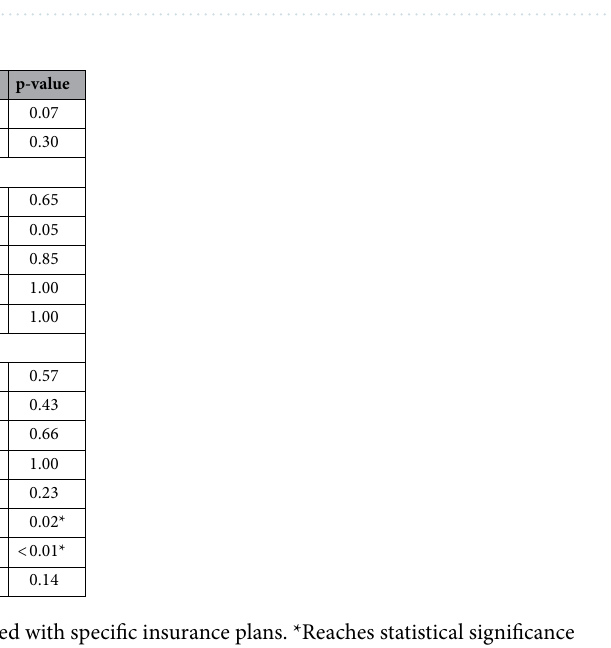
Table 2. Results of regression performed with insurance coverage as a binary variable. *Reaches statistical significance (p < 0.05).